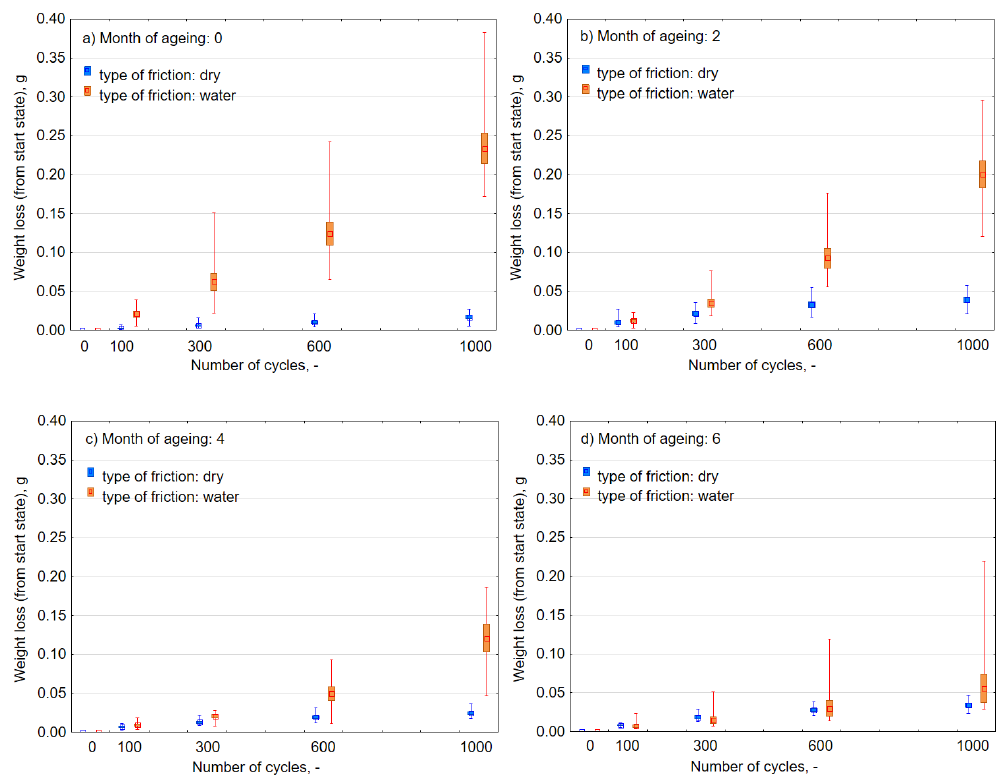
Figure 9. Average loss of the weight of samples that underwent weathering after the assumed number of cycles of dry and wet abrasion ( a ) 0, ( b ) 2, ( c ) 4, and ( d ) 6 months of UV-A impact.